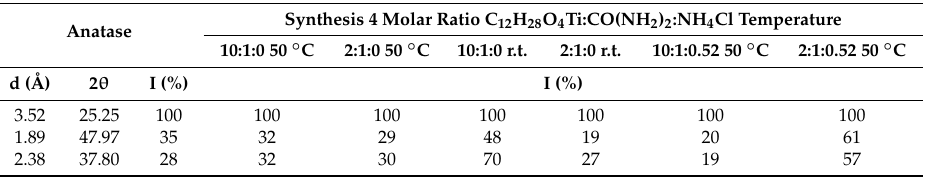
Table 6. Theoretical and experimental values for the diffraction analysis.